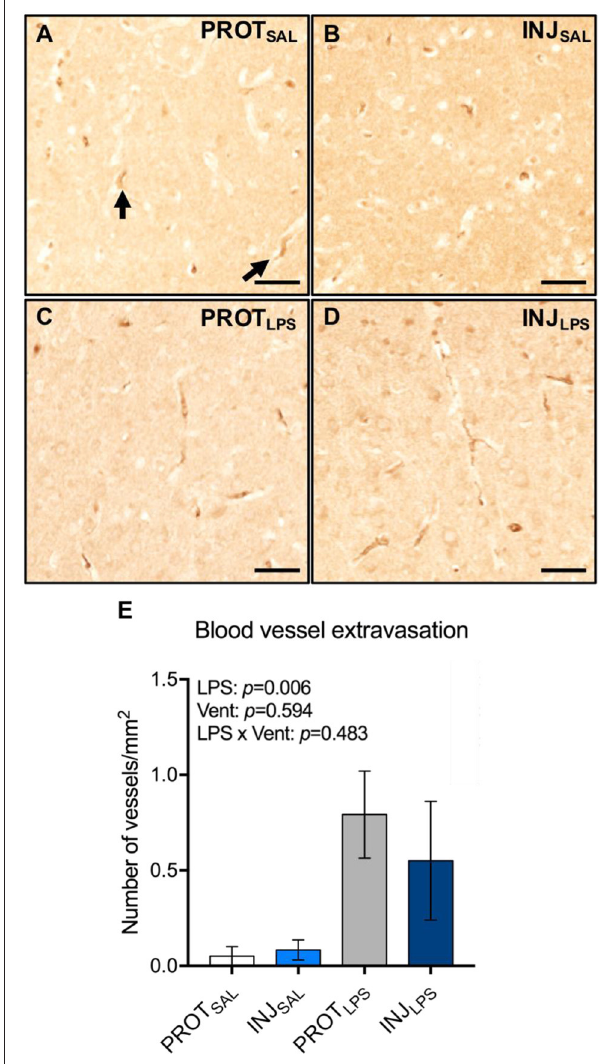
FIGURE 7 | LPS exposure is associated with vessel protein extravasation in the cortical gray matter . Representative images of blood vessels labeled for sheep serum in the gray matter (A–D) . LPS exposure leads to an increase in the number of blood vessels with protein extravasation (E) . Magnification = 4x, scale bar = 20 µ m. PROT SAL , N = 5; PROT LPS , N = 6; INJ SAL , N = 6; and INJ LPS , N =